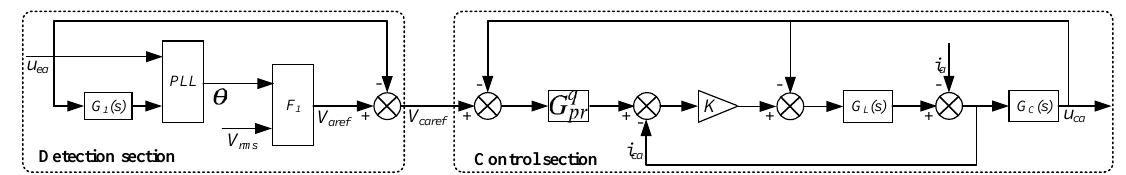
Figure 4. The proposed control algorithm of series converters.